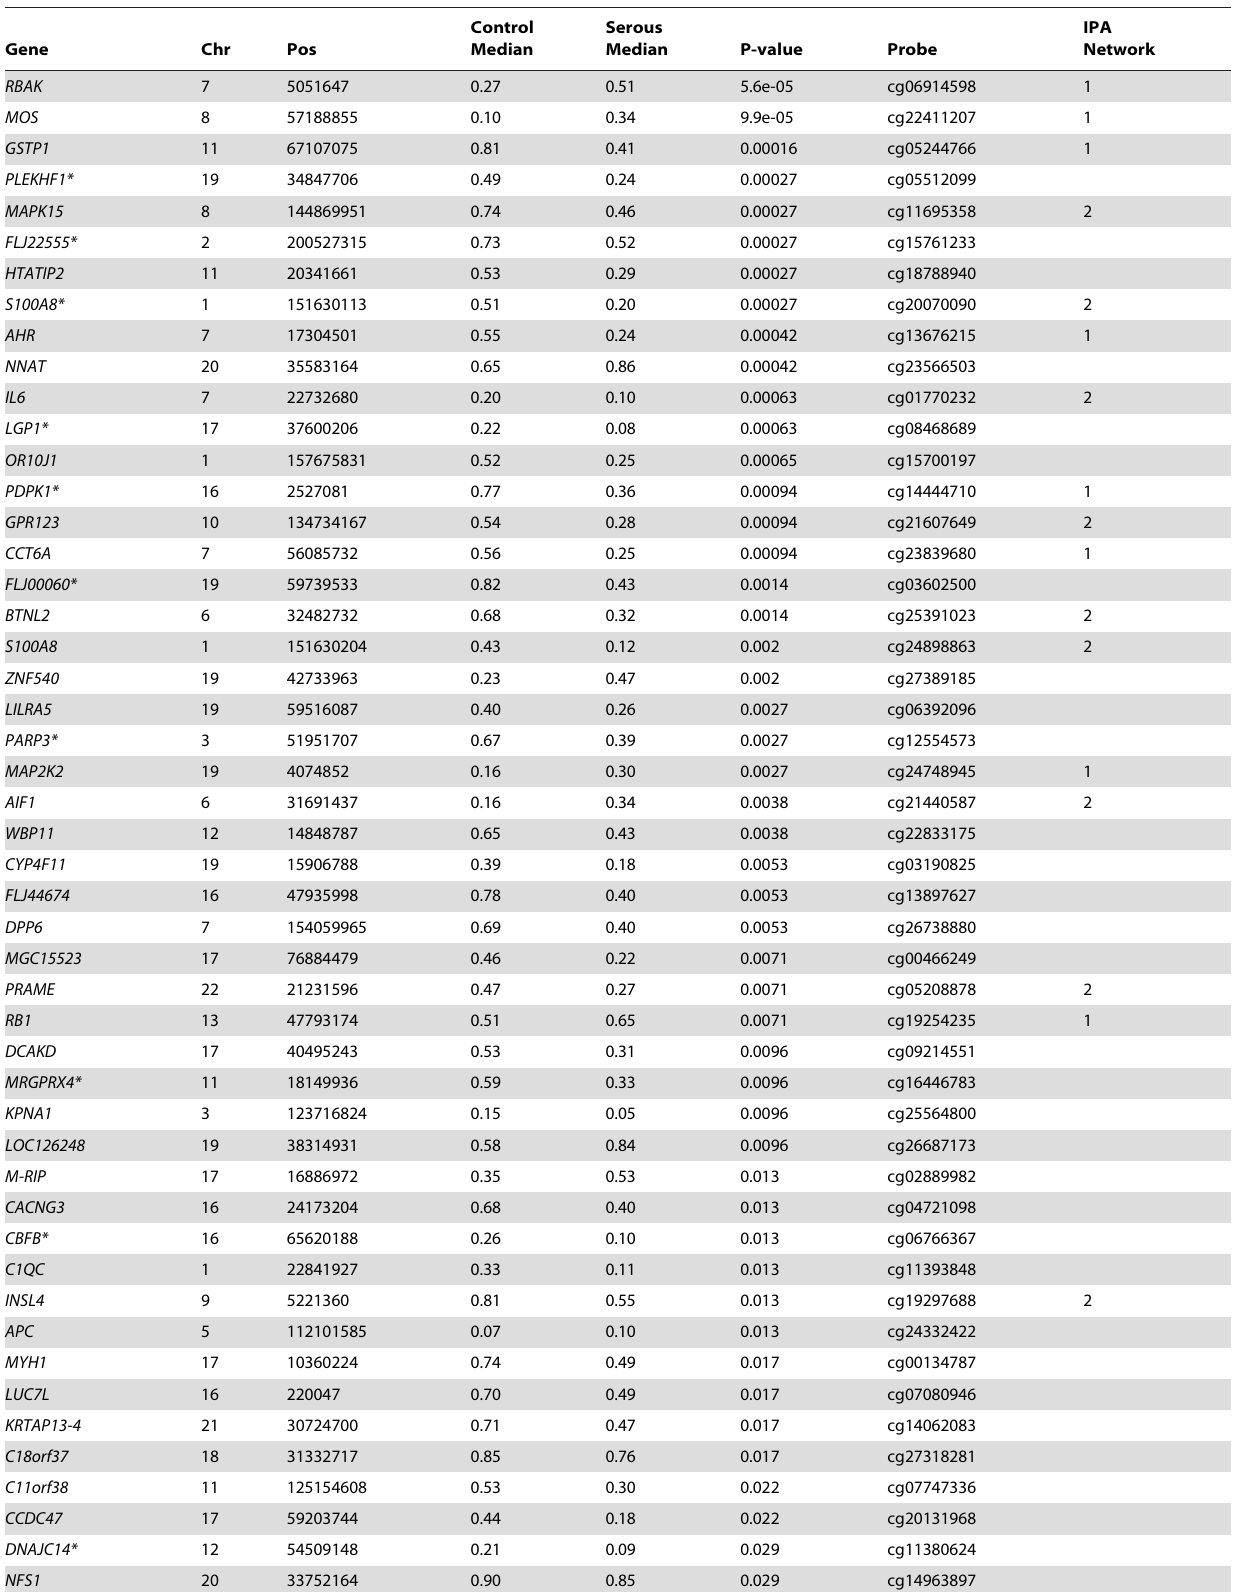
Table 3. Differential methylation of genes in cluster-based analysis, p ,